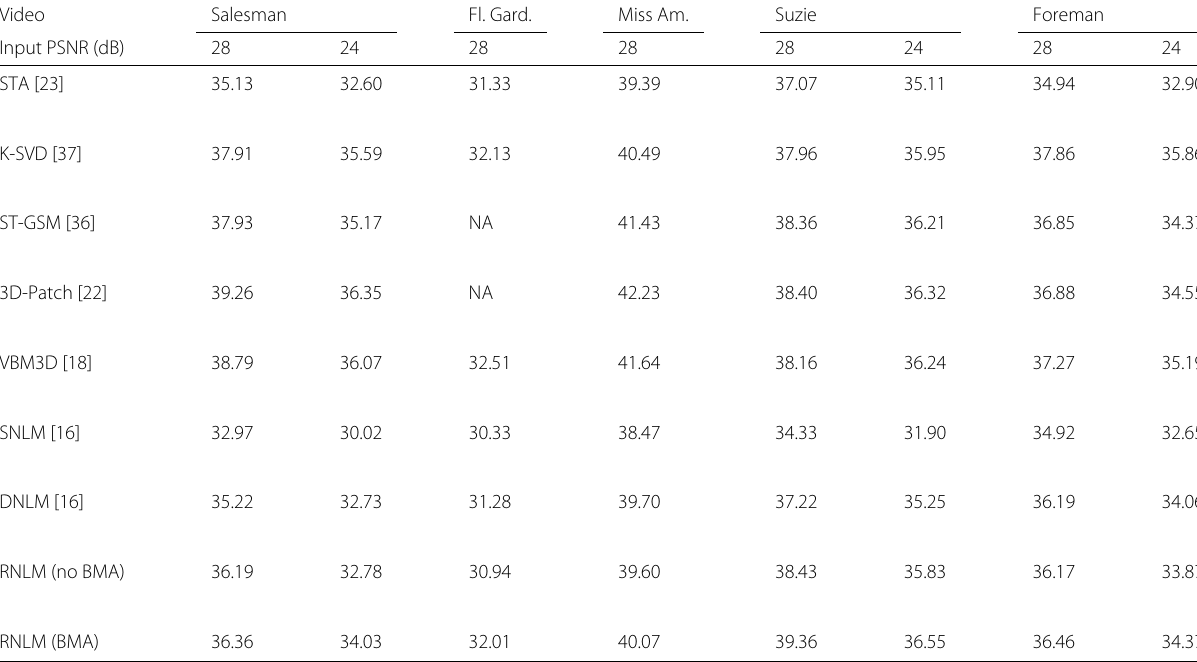
Table 4 Additional PSNR performance comparisons with various published results. All PSNR values are reported in decibel Video